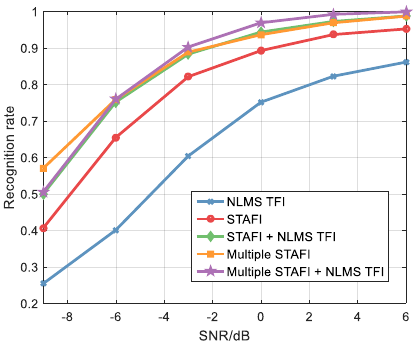
Figure 21. Recognition results according to different feature images .